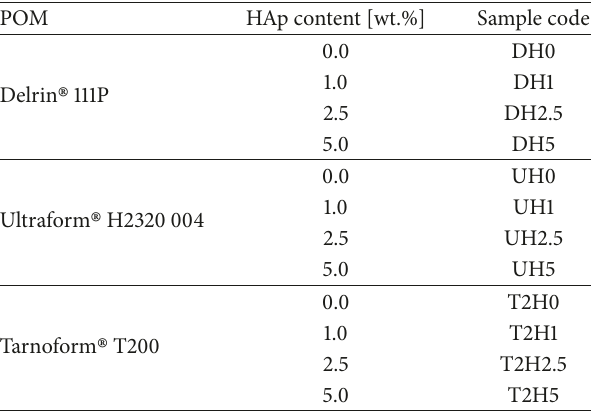
Table 1: Description of the